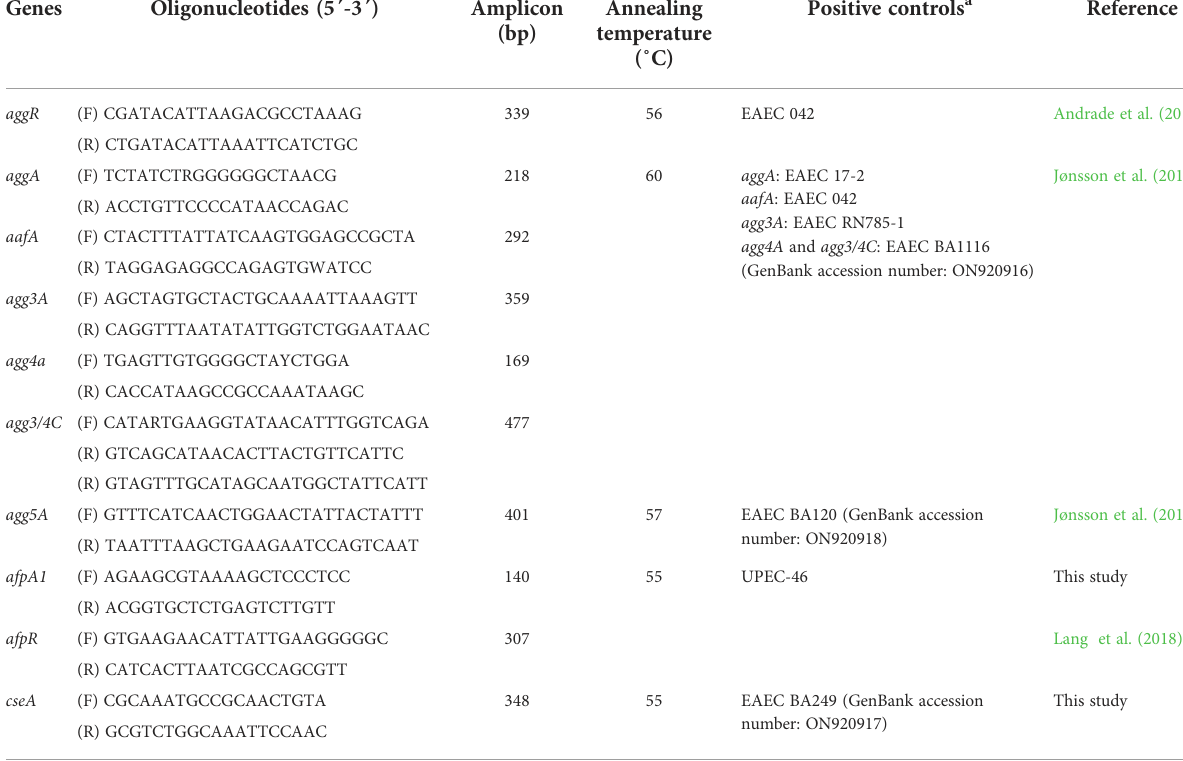
TABLE 1 – Oligonucleotide sequences and PCR conditions used for adhesin-encoding genes